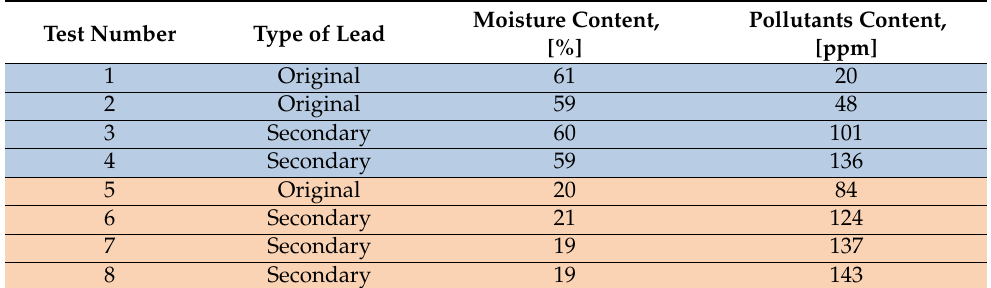
Table 2. Characteristics of the tests carried out (blue color—high humidity; brown color—low humidity).